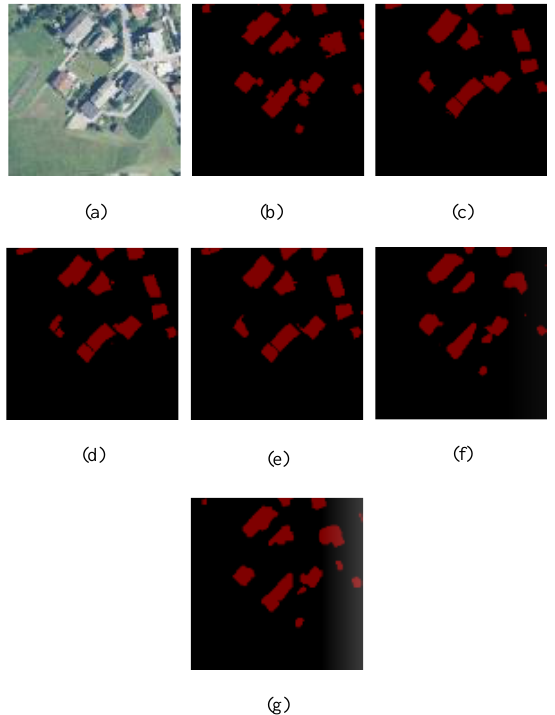
Figure 11. Comparison results results of semantic segmentation methods. ( a ) Input image; ( b ) ground truth; ( c ) ResNet50 + ASPP; ( d ) DeepLabV3+; ( e ) ENet; ( f ) ESPNet; ( g ) Our method (LResNet50 + WASP(AVE) +